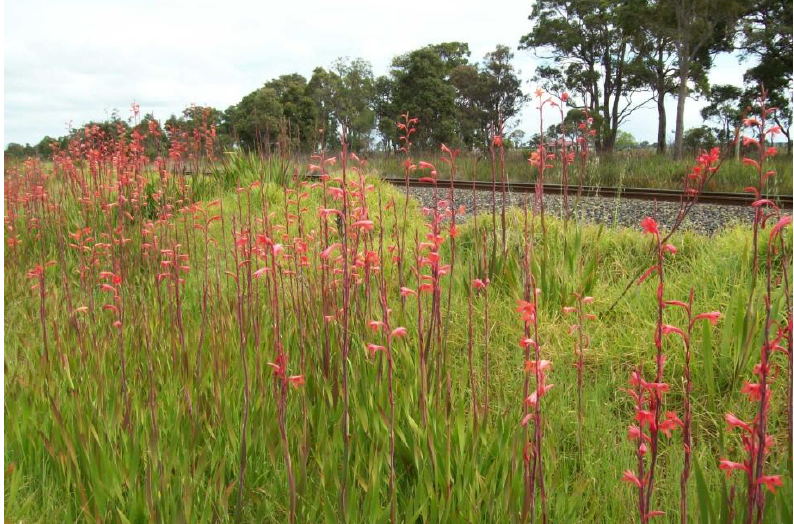
Figure 5. Exotic Gladiola spp. plants alongside a railway line near Bunbury, Western Australia. Termed ―invasive‖ and ―opportunistic,‖ weeds often exhibit adaptive group behaviors that enable them to establish vigorous populations around the world.